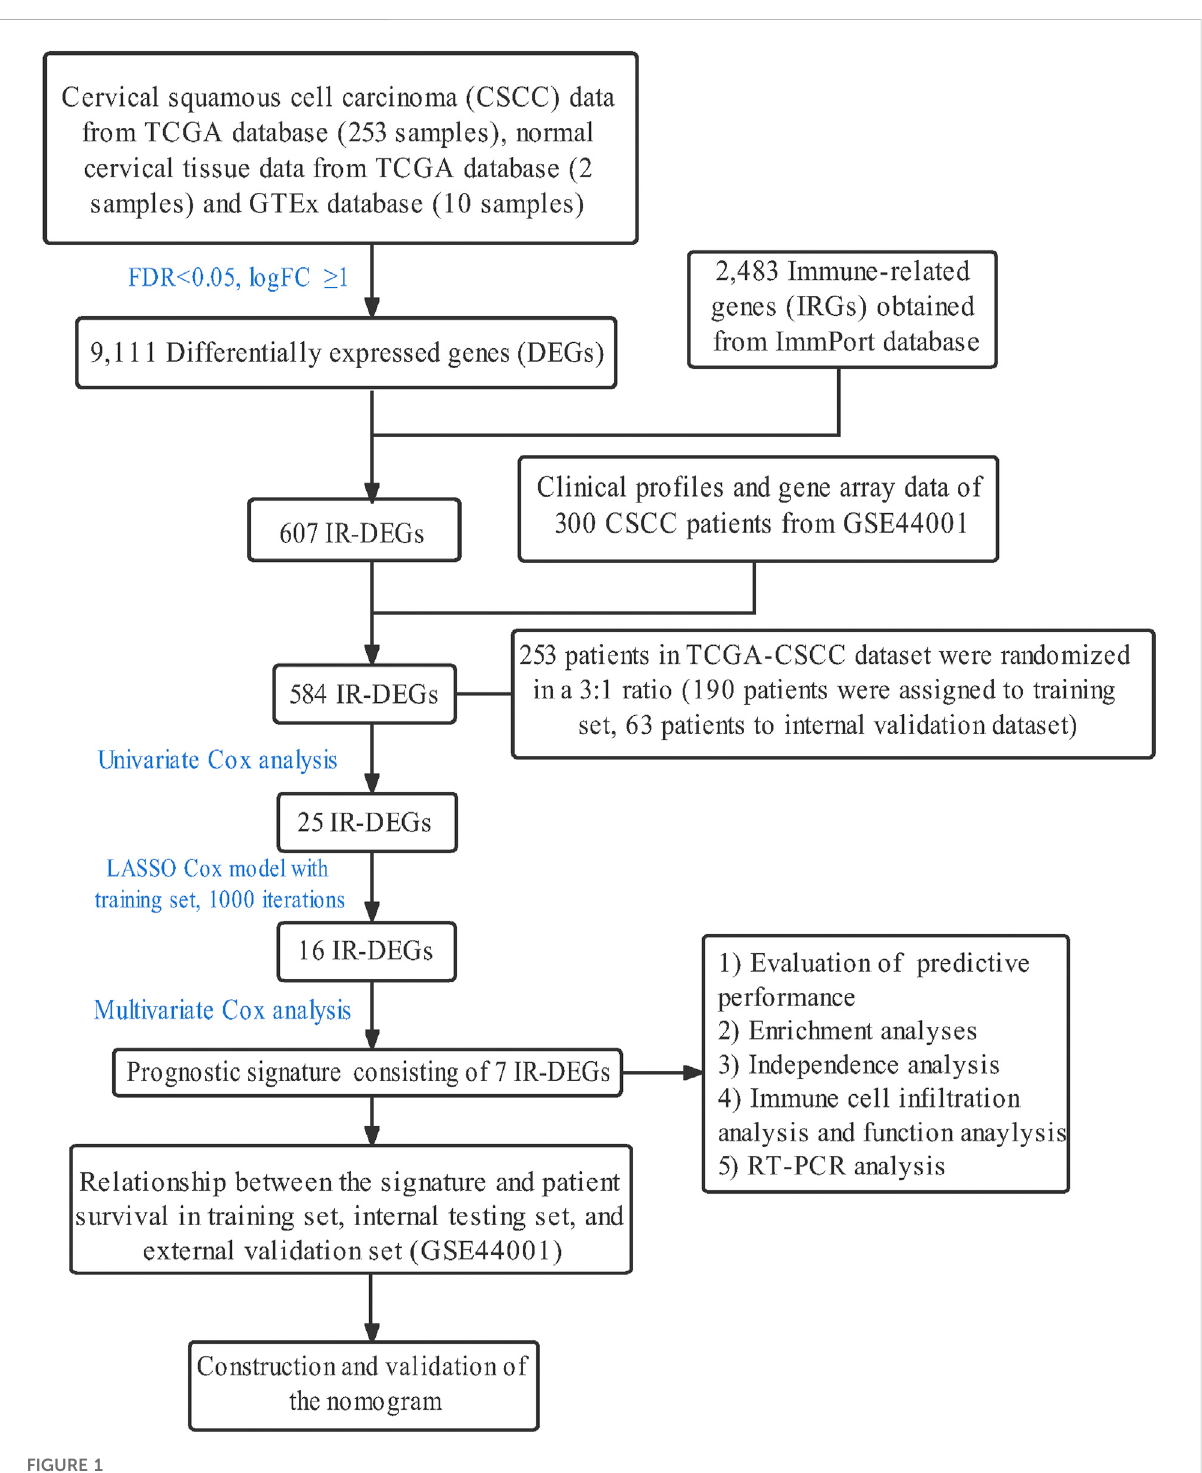
FIGURE 1 The fl owchart of the present